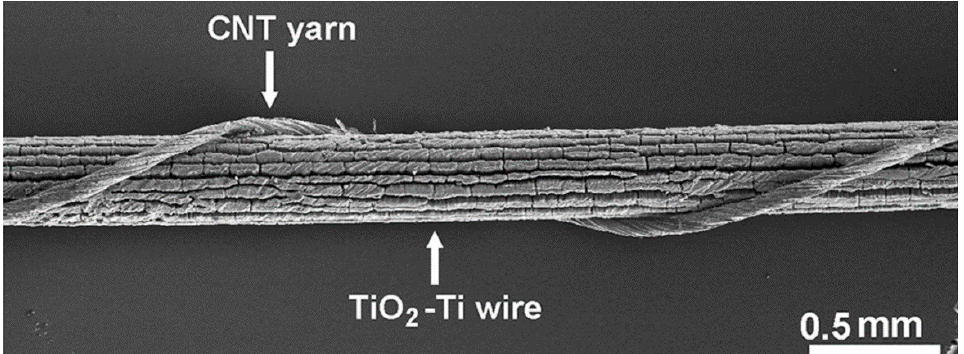
Figure 11. SEM image of a TiO 2 -Ti wire primary electrode diameter twisted around a carbon nanotube (CNT) yarn counter electrode. Reprinted (adapted) with permission from [133]. Copyright 2012 American Chemical Society.